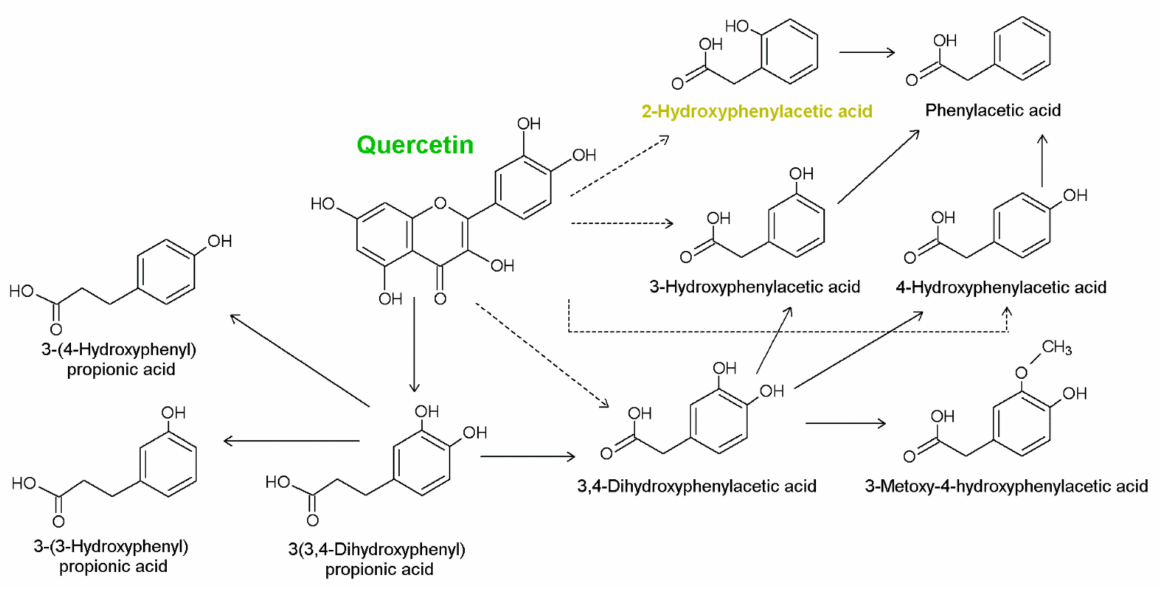
Figure 1. Possible pathways of quercetin degradation of by intestinal bacteria (on the basis of data from [6]). 2-hydroxyphenylacetic acid (2-HPAA) (Figure 2) is a natural phenolic